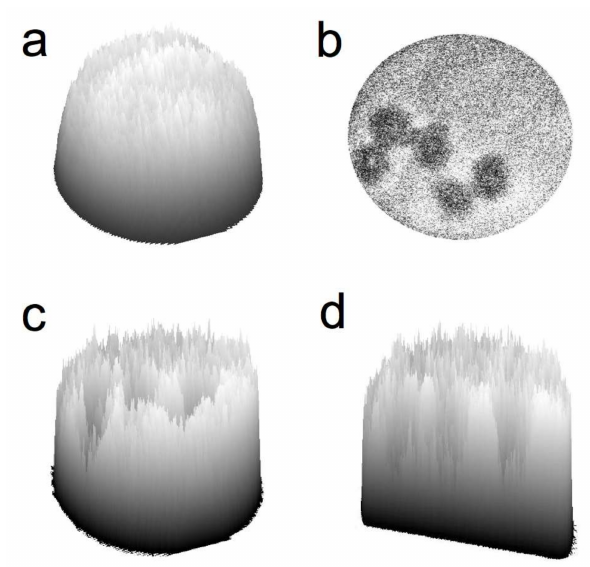
Figure 2. Scanning confocal microscopy images of BSA-treated hydrogels, 22 wt % 2:1 PEG-(CHO) 2 :PEG-(Lys) 2 . Emission was collected at 460 nm, subtracted from slide background, and normalized to 8-bits/pixel. ( a ) 3D surface plot of a hydrogel chamber in the absence of cell adhesion, ( b ) 2D depiction of cells masking hydrogel emission fluorescence, ( c ) 3D surface plot of the hydrogel shown in b, and ( d ) 3D cross-section of the hydrogel shown in b